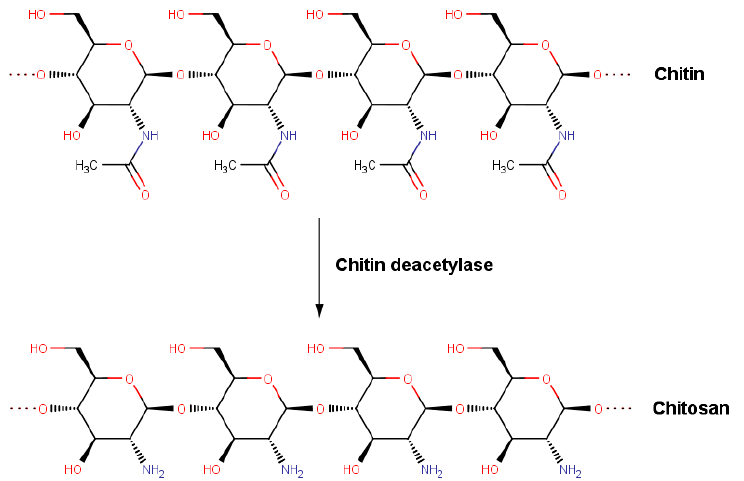
Figure 1. Deacetylation of chitin into